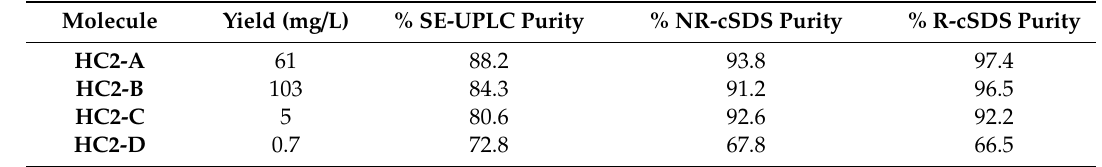
Table 3. Yields and SE-UPLC, NR-cSDS, and Red-cSDS purities tabulated for four HC2s expressed as HC-only transient transfections at 3 L scale followed by ProA a ffi nity capture.